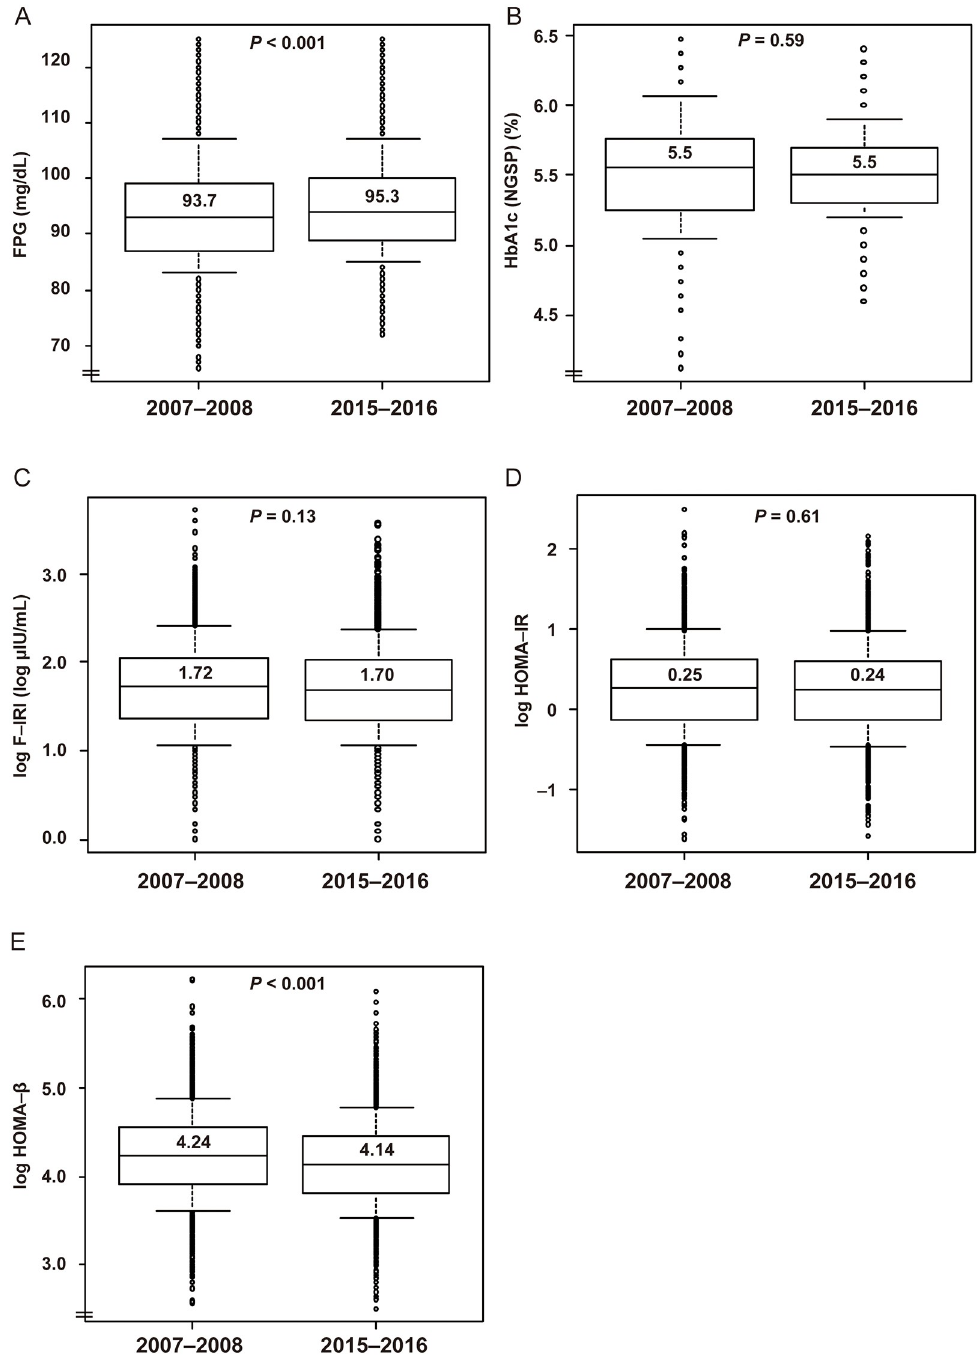
Fig 3. Box-and-whisker plots for FPG, HbA1c, F-IRI, HOMA-IR, and HOMA- β in men. Whiskers indicate the 10th and 90th percentiles. The Y axes do not start at zero in panels A, B, D, or E. F-IRI, HOMA-IR, and HOMA- β (Y-axes) are plotted on a natural logarithmic scale. Abbreviations: FPG, fasting plasma glucose; HbA1c, glycated hemoglobin; F-IRI, fasting immunoreactive insulin; HOMA- β , homeostasis model assessment of insulin secretion; and HOMA-IR, homeostasis model assessment of insulin resistance. P -values were determined using Welch’s t -test. N = 1,570 for each group.